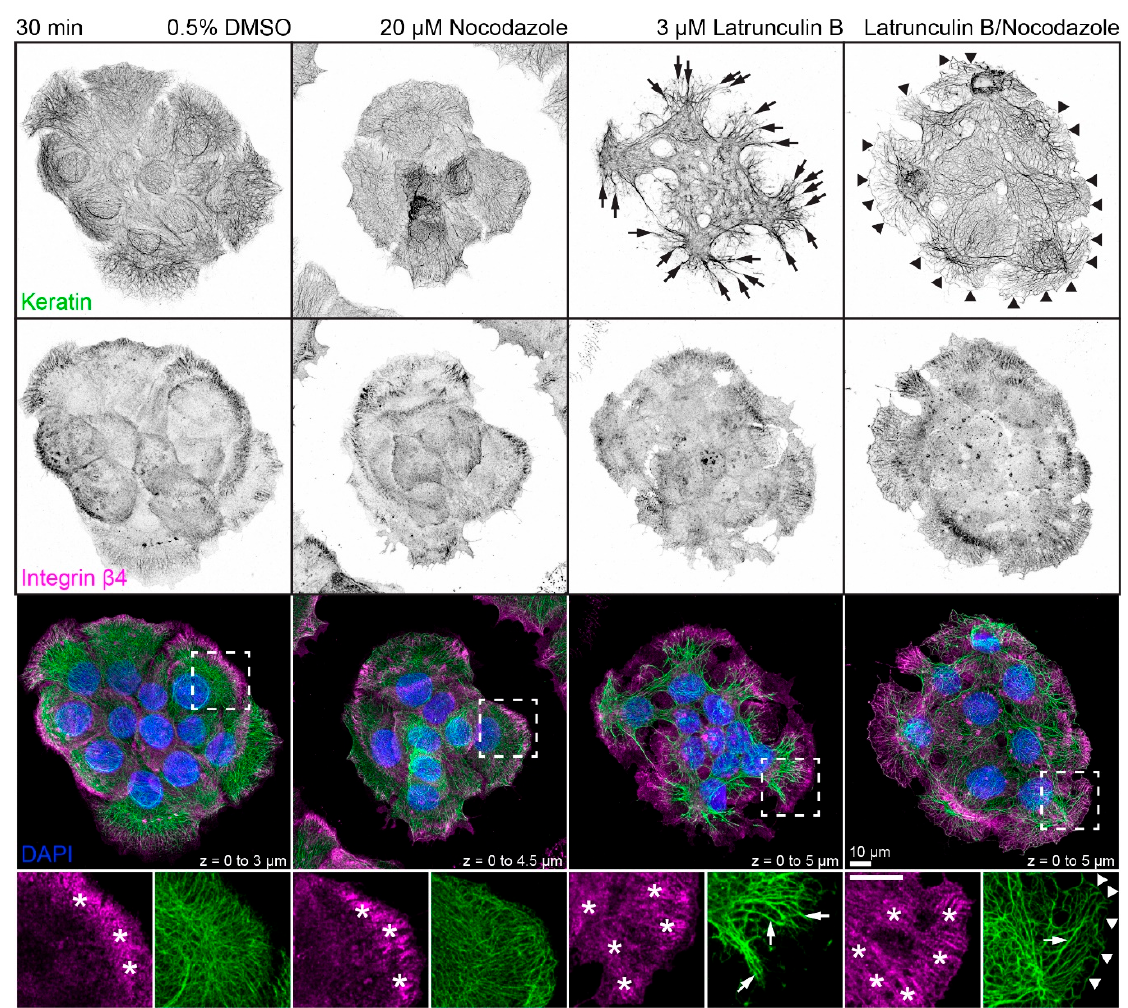
Figure 2. Disruption of actin filaments and microtubules alone or in combination leads to different changes in keratin filament network architecture in each situation. The triple fluorescence micrographs (enlargements of boxed areas in the bottom panel) show the immunodetection of keratins (top panel) and integrin β 4 (middle panel), together with nuclear DAPI (merged images in lower panel), in methanol-fixed HaCaT keratinocytes. The actin cytoskeleton was disrupted by treating cells with 3 µM latrunculin B and the microtubule cytoskeleton was disrupted by treating cells with 20 µM noco- dazole for 30 min. The dimethyl sulfoxide (DMSO) control on the left shows examples of typical keratin networks and hemidesmosomal distribution in untreated HaCaT cells. Note that the integrin β 4-demarcated hemidesmosomal patterns (asterisks) are not affected by drug treatment, for the most part. On the other hand, major keratin filament network retrac- tion is seen in latrunculin B treated cells (arrows), which is less pronounced in latrunculin B/nocodazole-treated cells (ar- rows) and not apparent in cells treated with nocodazole alone. Note also that prominent keratin bundles are present at the